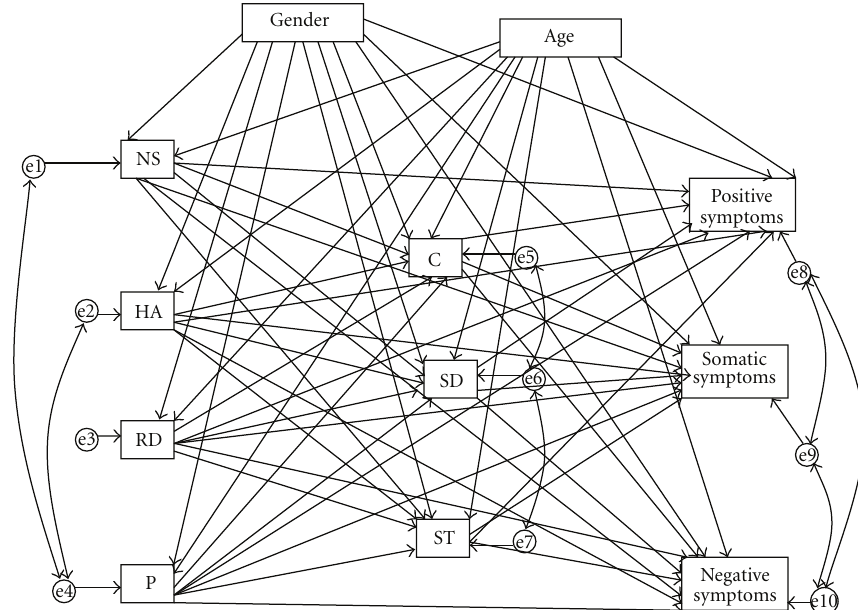
Figure 1: The original model. NA: negative a ff ectivity; NS: novelty seeking; HA: harm avoidance; RD: reward dependence; P: persistence; SD: self-directedness; C: cooperativeness; ST: self-transcendence. The correlations among error variables in temperament/character dimensions were not